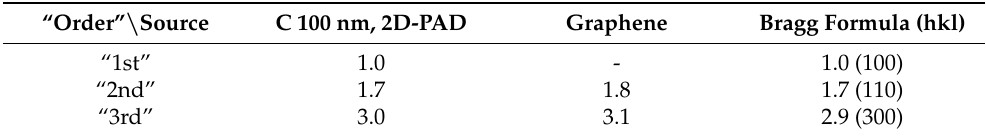
Table 1. Comparison of diffraction angles (in degrees) for rings or spots for carbon-based materials measured at 30 keV. The experimental data are from C 100 nm thin foil diffraction maxima, Figure 8, and graphene diffractogram from reference [57] (Figure